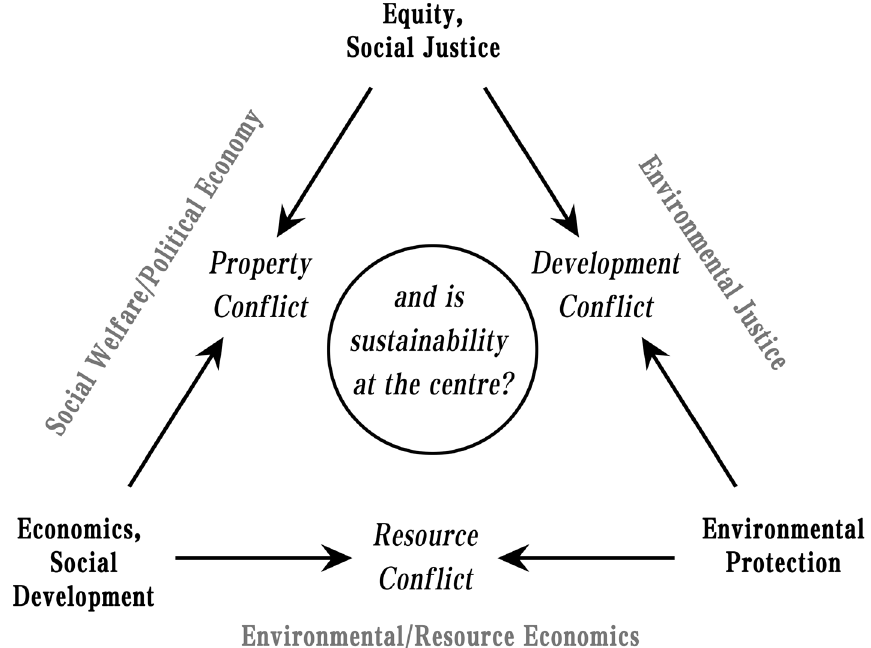
Fig. 4 Planner ’ s triangle for sustainable development by Scott D. Campbell. (Source: Campbell 2016; Modified and Redrawn by the author